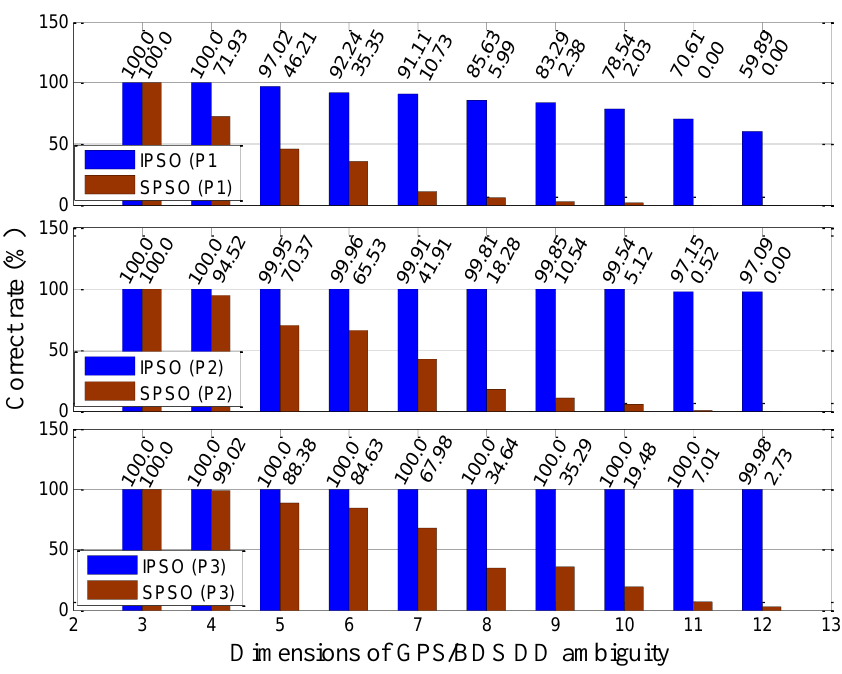
Figure 8. Correct rates of IPSO/SPSO–AR under various DD ambiguity dimensions in Scheme #2.